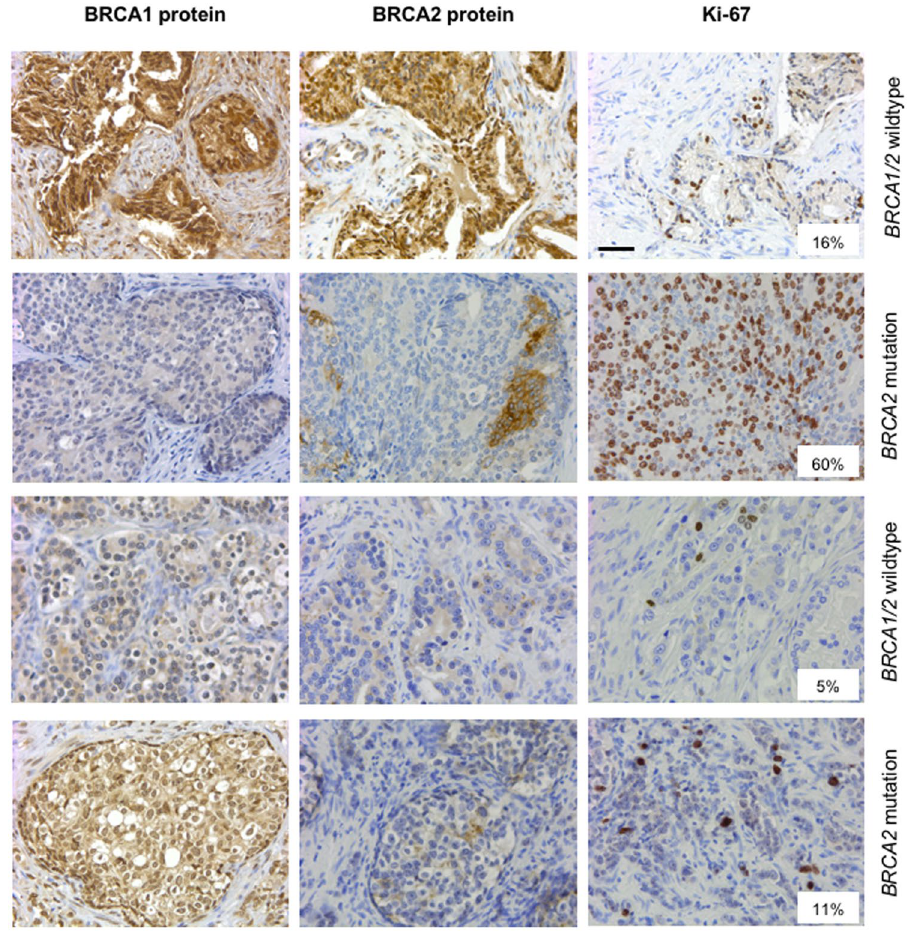
Figure 3. Heterogeneity in BRCA1/2 protein expression and BRCA1 / 2 mutational status. Immunohistochemical staining for BRCA1, BRCA2 or Ki-67 in four representative tumors. Note that the two BRCA1 / 2 wildtype tumors showed either a strong nucleocytoplasmic expression of both BRCA1 and BRCA2 or a weak cytoplasmic expression of both proteins. BRCA2 mutated tumors show a partial loss of BRCA2 protein expression but such a loss was also detectable in BRCA1 / 2 wildtype tumors (e.g., second row from the bottom). Scale bar = 50 µ